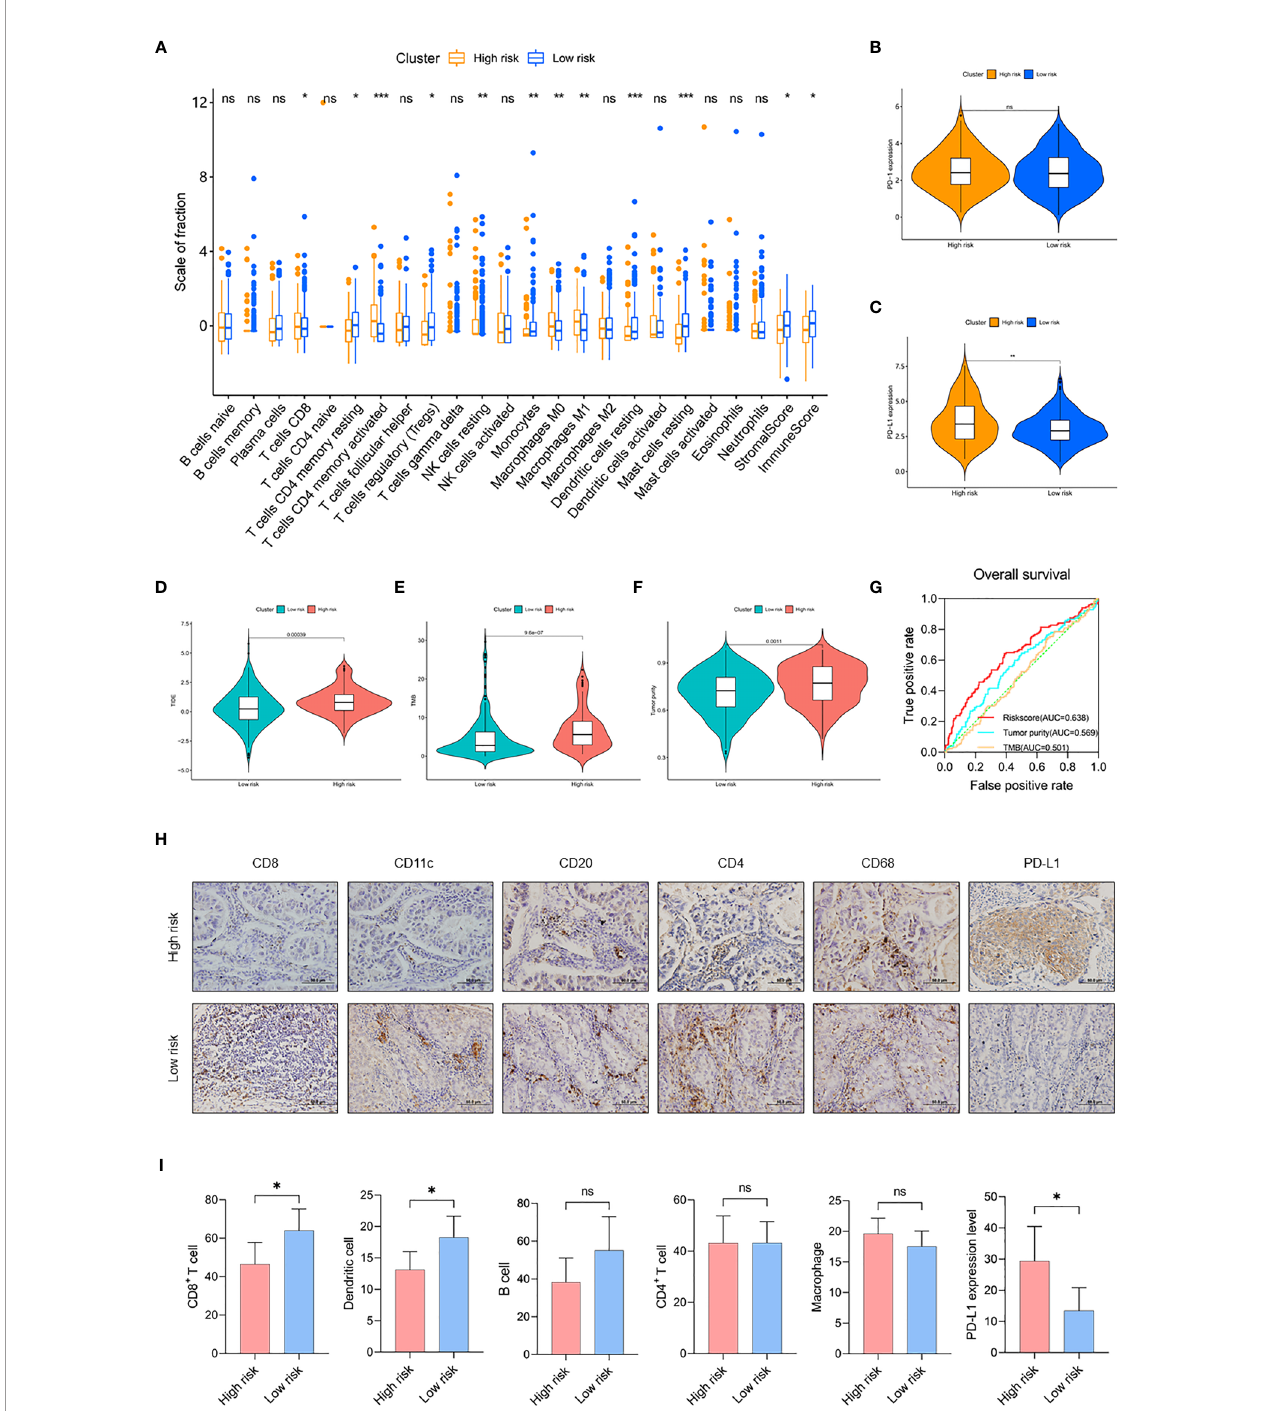
FIGURE 5 | Comparison of TIME between risk subgroups. (A) The fractions of 22 immune cell types, stromal score, and immune score in the high-risk group (n = 133) and low-risk group (n = 301) of the TCGA cohort. (B, C) Expression level of PD-1 (B) and PD-L1 (C) in risk subgroups of the TCGA cohort. (D – F) Value of (D) TIDE, (E) TMB, and (F) tumor purity in risk subgroups of the TCGA cohort. (G) Time-dependent ROC curves measuring the predictive value of the risk score, TMB, and tumor purity in the TCGA cohort. (H) Representative IHC images for staining of CD8+ T cell, CD11c+ DC, CD20+ B cell, CD4+ T cell, CD68+ macrophage, and PD-L1 classi fi ed by risk score in 100 samples of LUAD patients from Tianjin (Olympus, ×400 magni fi cation, bar = 50 m m). (I) The counts of CD8+ T cell, DC, B cell, CD4+ T cell, and macrophage and the expression level of PD-L1 in the Tianjin cohort. High-risk group (n = 52) and low risk group (n = 48). Mean with 95% CI; *p < 0.05, **p < 0.01, and ***p < 0.001. ns, not statistically signi fi